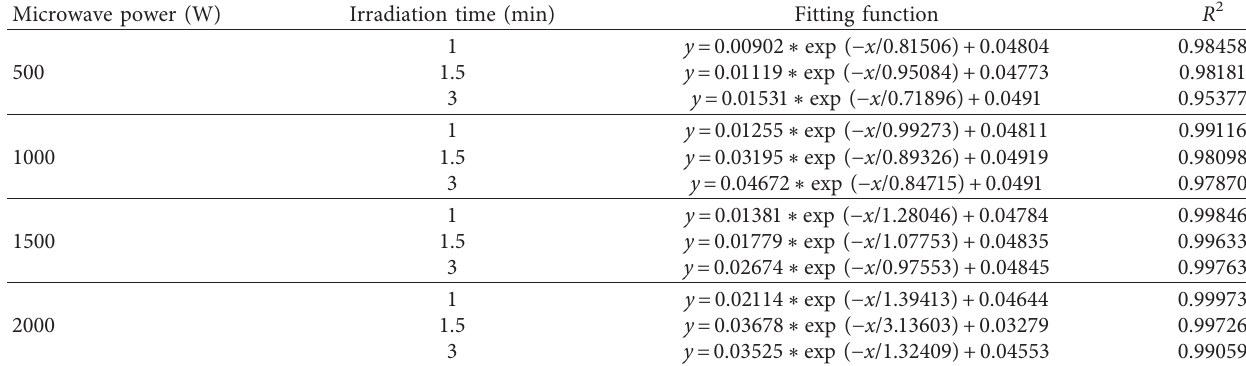
Table 3: Fitting results for permeability under a confining pressure of 3MPa.